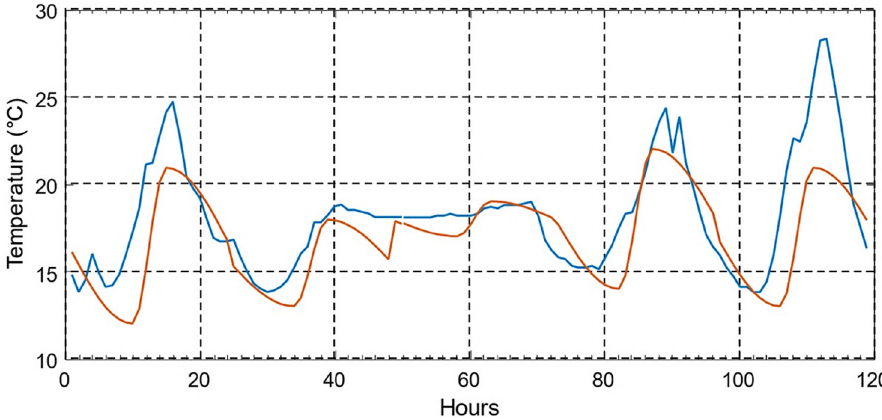
Figure 40. Simulated (blue) and measured (orange) ambient temperature for January.